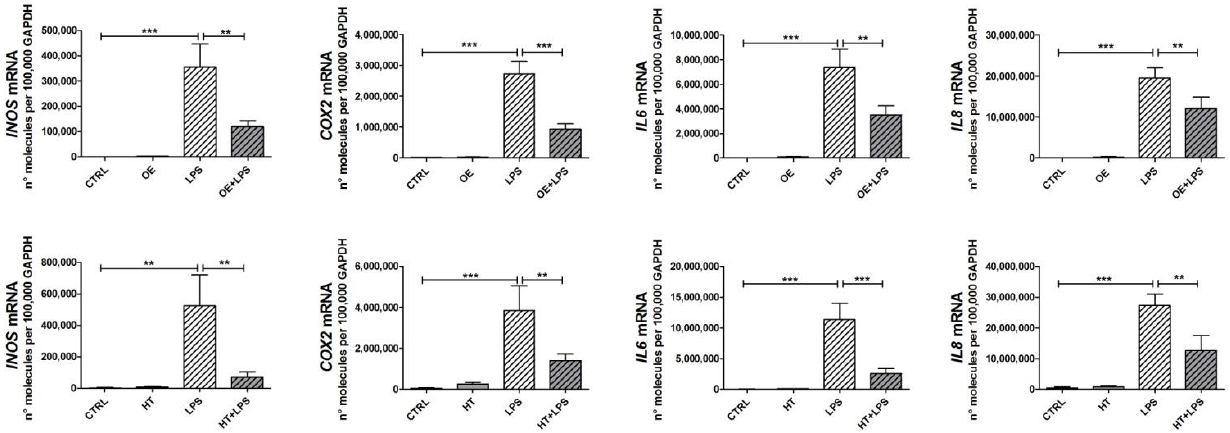
Figure 3. Effects of OE and HT on inflammatory markers. LPS treatment increases markers of OA in primary OA chondrocytes and pretreatment with either OE ( upper graphs ) or HT ( lower graphs ) efficiently inhibits this effect. Results are means ± SEM ( n = 5 to 9 different primary chondrocyte cultures), normalized using the reference housekeeping gene GAPDH according to the formula 2 −ΔCt and expressed as number of molecules per 100,000 GAPDH molecules. Statistical analysis was performed by ANOVA, followed by Newman–Keuls’ post hoc test, with * p < 0.05, ** p < 0.01, *** p < 0.001.